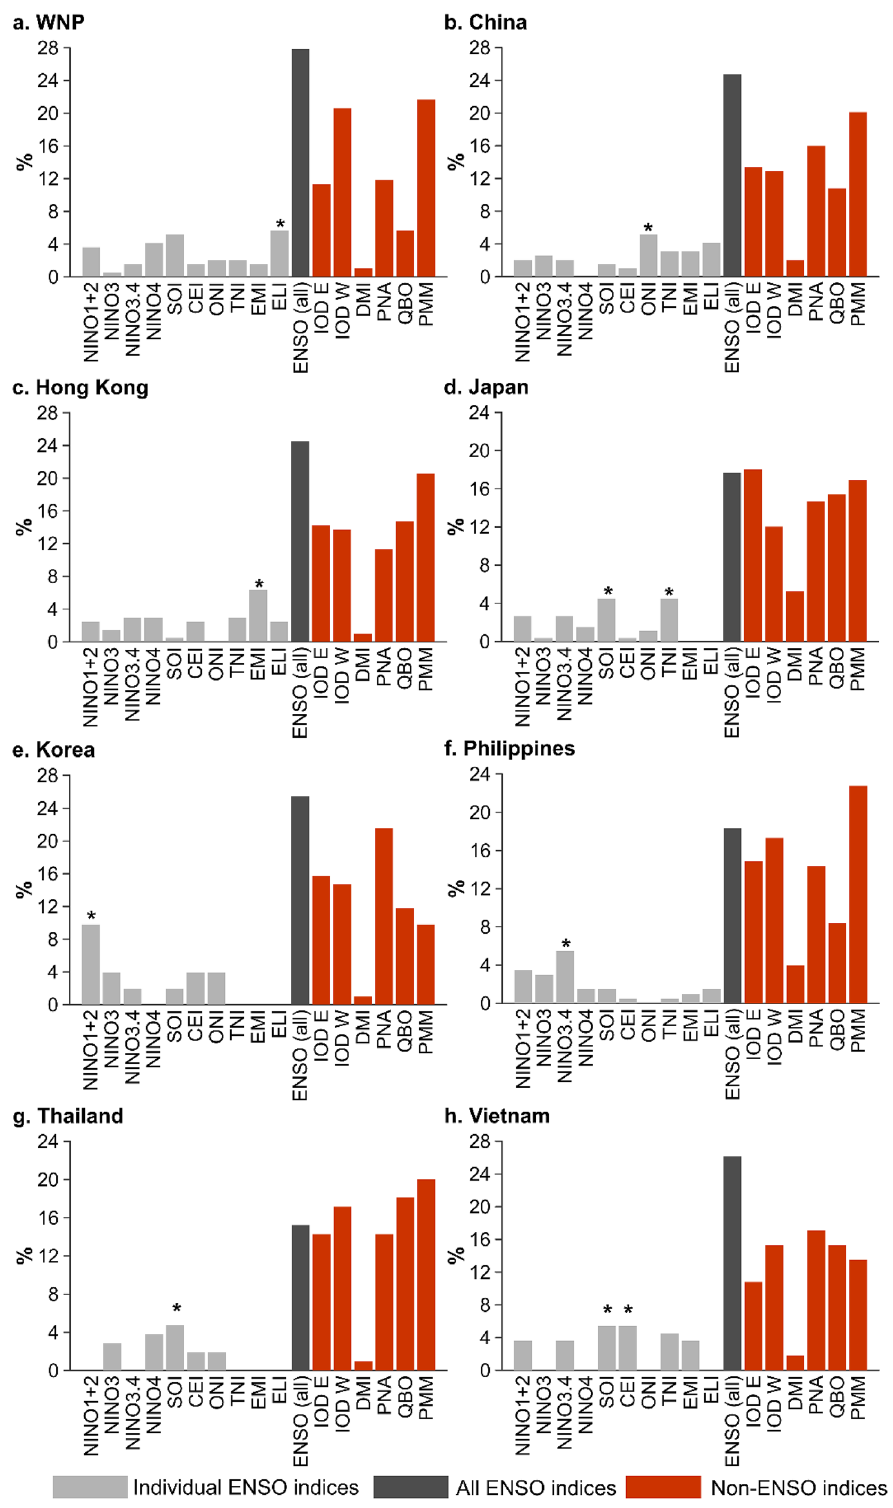
Figure 7. Proportion (%) of selected model covariates using the automated variable selection procedure for all outlook model runs (TY, STY and TY + STY) and nine model initialisation lead times. Light grey bars represent individual ENSO indices (note that the proportion of individual ENSO indices should not be compared with all ENSO indices (dark grey bar) and non-ENSO indices (red bars) as not all ENSO indices feature in each model run). All ENSO indices (dark grey bar) represents the aggregate proportion of individual ENSO indices and can be compared with non-ENSO indices (red bars). The asterisk indicates the most commonly selected ENSO